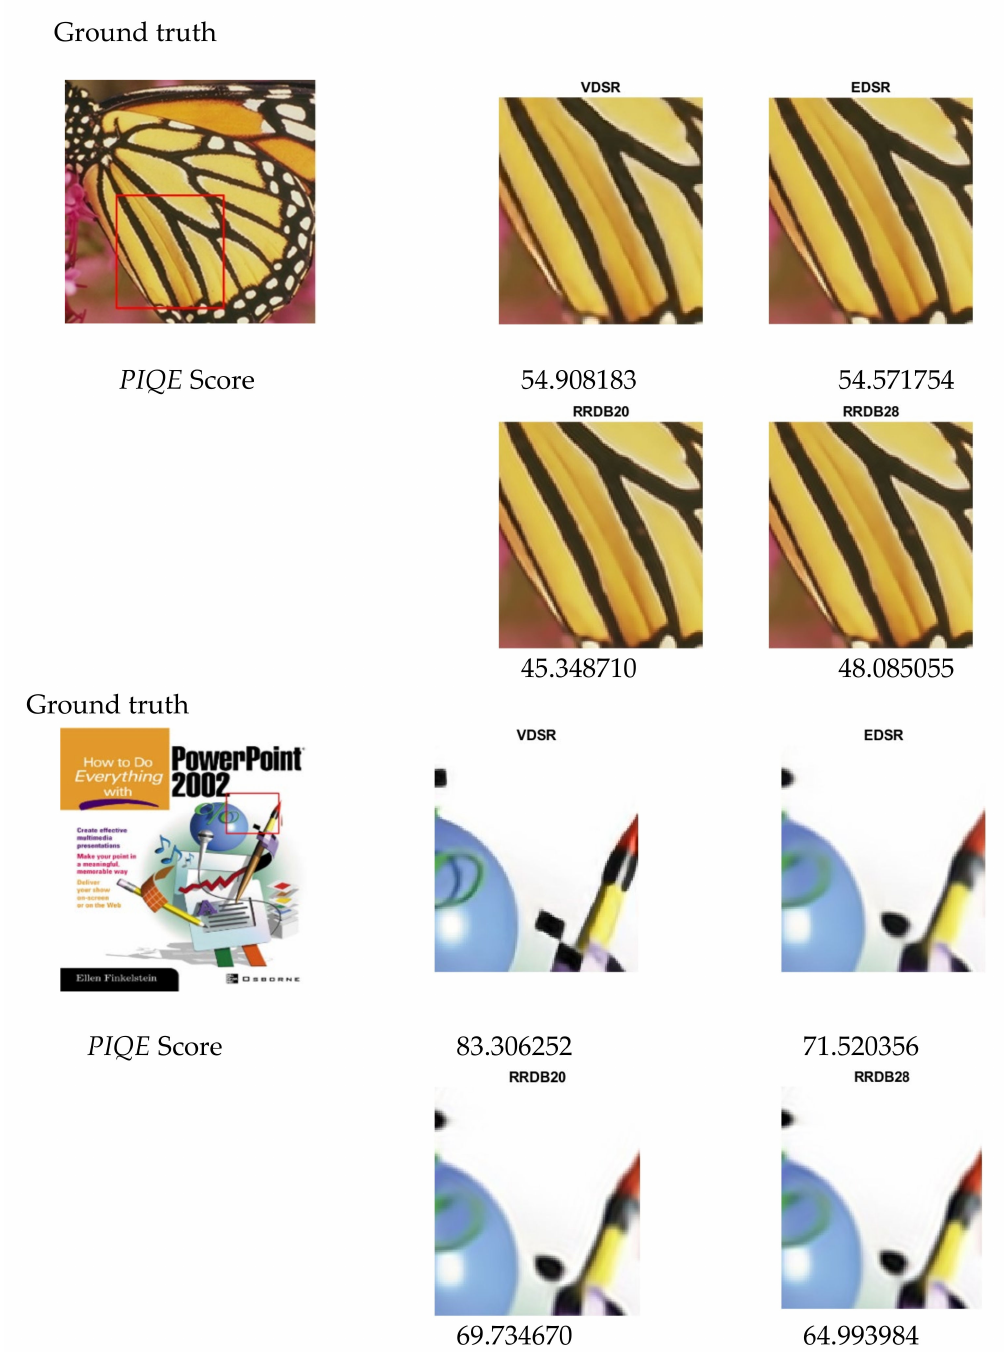
Figure 7. Perceptual evaluation of proposed models on set 5 ( × 4) and set 14 ( × 8)